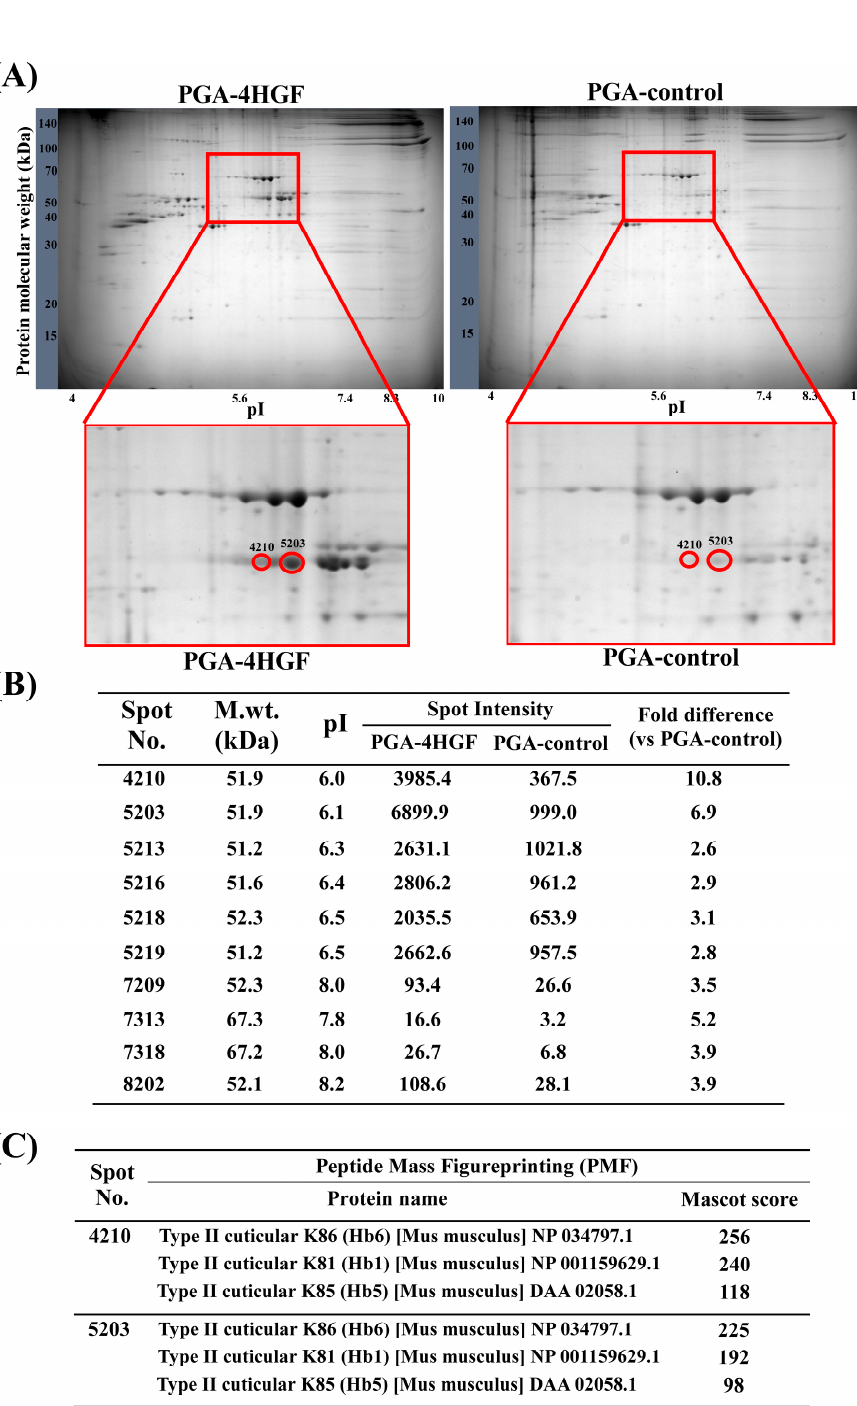
Figure 7. Characteristics of PGA-4HGF treated hair keratin proteins. ( A ) Two-dimensional electrophoresis (2-DE) separation of protein extracted from the dorsal tissues treated PGA-4HGF or PGA-control for 12 days using isoelectric focusing (IEF) strips and SDS-PAGE. ( B ) The protein spots detected from 2D gels and analyzed by the PDQuest (version 7.0, BioRad) software. The isoelectric point (pI) separation was done from pH 4 to 8. The molecular weight (M.wt) separation was done from 50–70 kDa. ( C ) The selected spots were analyzed using peptide mass fingerprinting (PMF).